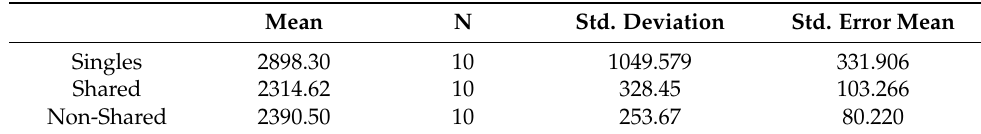
Table 4. Overall descriptive data time spent on task completion (in seconds).